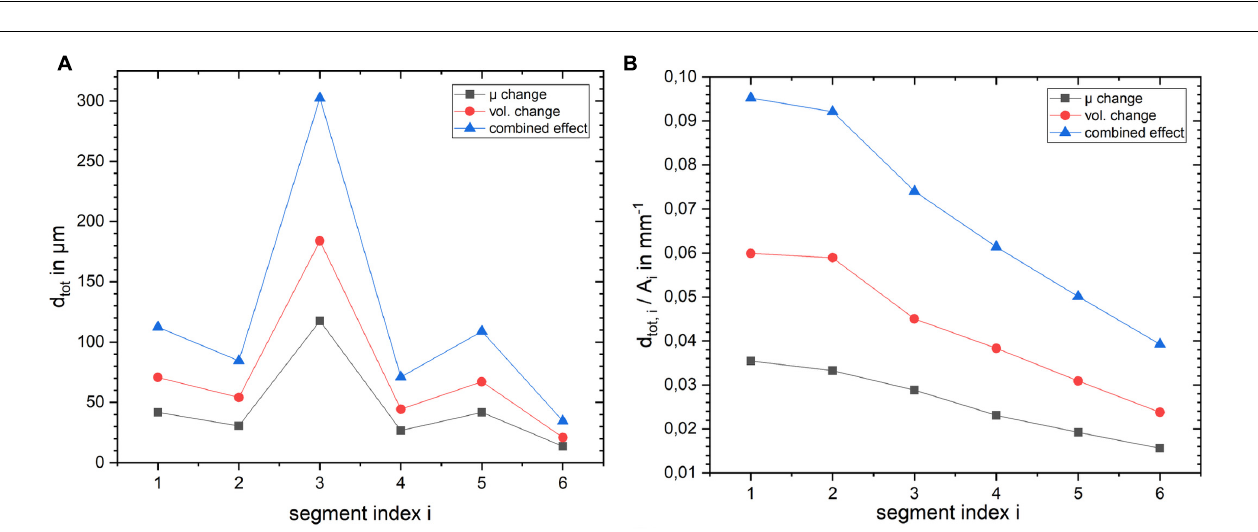
FIGURE 6 | Influence of layer position within the cortical segment on (A) absolute displacement for the three different scenarios and (B) displacement normalized by the layer segment